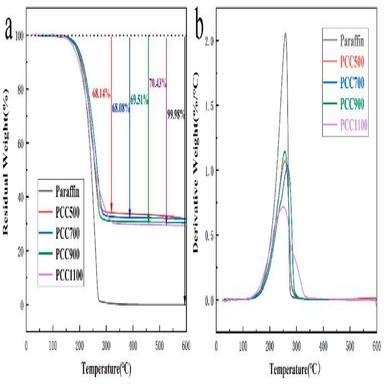
TGA(a) and DTG (b) curves of paraffin and PCCs.